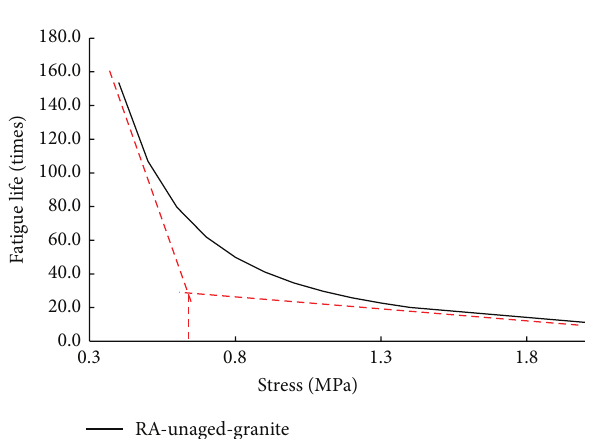
Figure 9: Schematic view for critical stress amplitude of fatigue curve.